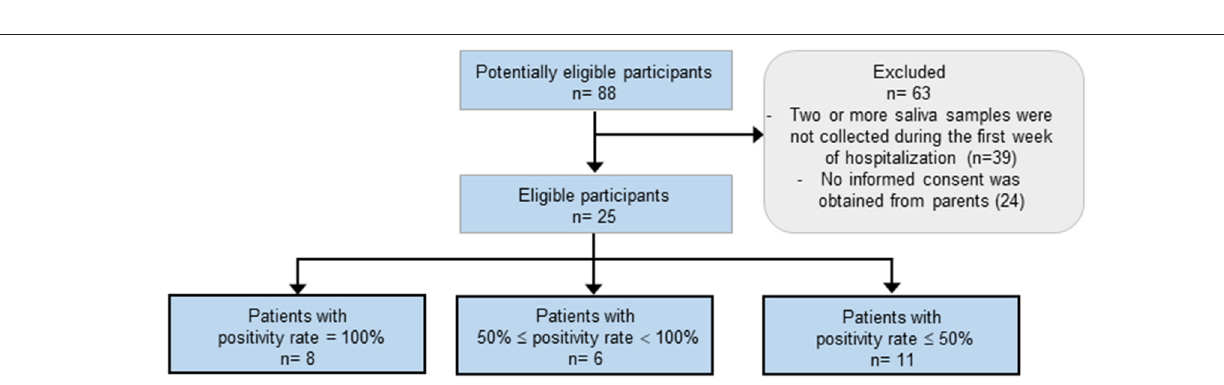
preoperative laboratory tests. In the case of hospitalized patients, eligible participants were identified on the basis of the presence of symptoms related to SARS-CoV-2 infection. Matched NP/OP swab and saliva sample pairs were collected from: (i) 54